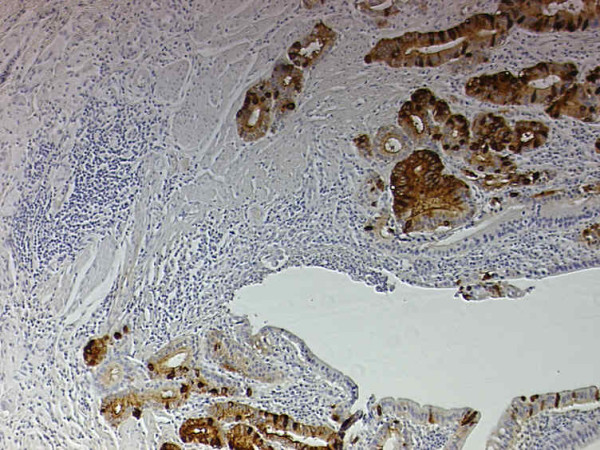
Strong immunoreactivity for Chromogranin A of carcinoid tumor infiltrating the muscular layer of the intestinal wall is clearly evident. The deep ulcer of CD is also present. (Magnification: ×25; Chromogen diaminobenzidine).